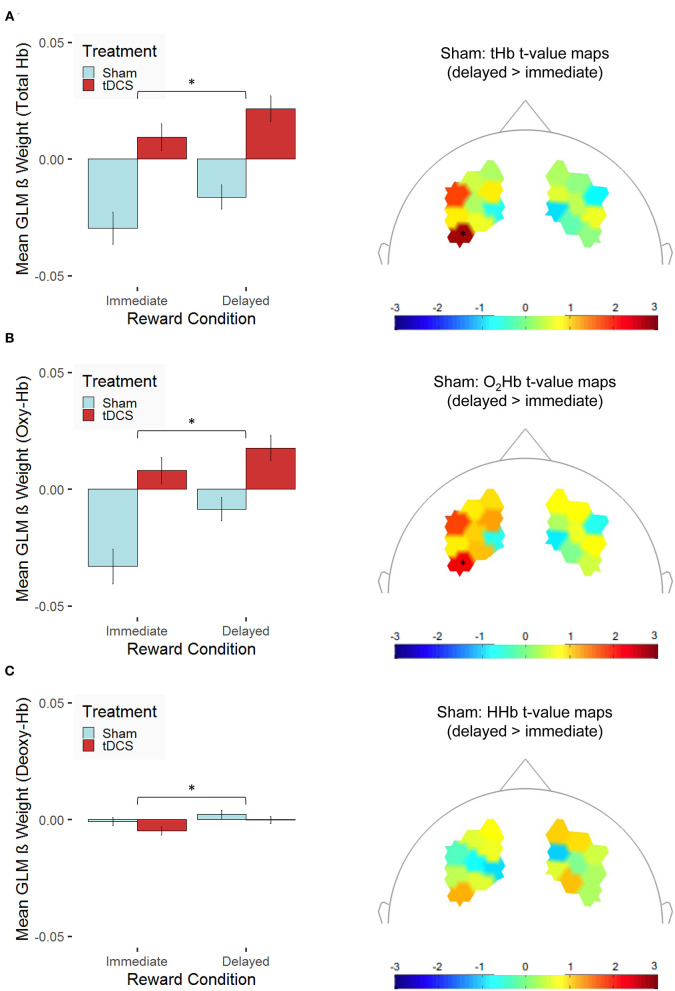
Hemodynamic concentration changes in the dorsolateral prefrontal cortex are presented for (A) total hemoglobin (tHb), (B) oxygenated hemoglobin (O2Hb/Oxy-Hb), and (C) deoxygenated hemoglobin (HHb/Deoxy-Hb). The left panel presents mean β values [error bars indicate 1 standard error (SE) of the mean, *p < 0.05 for post-hoc multiple comparisons after Holm correction] across all channels separated for the two experimental conditions (immediate vs. delayed reward) for participants, who received bilateral active transcranial direct current stimulation (tDCS; red) compared with sham stimulation (sham; blue). To prove whether functional near-infrared spectroscopy (fNIRS) is suitable to capture condition-specific activation patterns as functional magnetic resonance imaging (fMRI) does, the right panel indicates t-value maps depicting the contrast between the experimental conditions (delayed > immediate reward) only for participants, who received sham stimulation, unthresholded (* indicates thresholded t values with p < 0.05 before correcting for multiple testing; none of these values survives Holm correction).